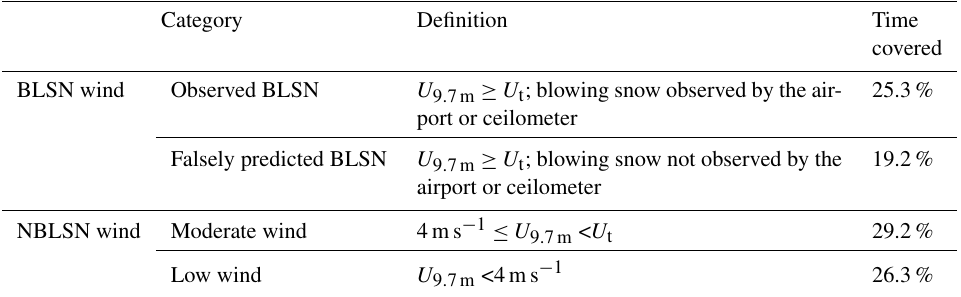
Table 1. Definitions of observed blowing snow (BLSN), falsely predicted BLSN, moderate wind speed, and low wind speed periods. The BLSN wind and non-blowing snow (NBLSN) wind periods are separated based on the comparison of measured 9.7m wind speed ( U 9 . 7m ) with a calculated threshold blowing snow wind speed ( U t ) (Li and Pomeroy, 1997). Time covered is the percentage of time classified in each period during the